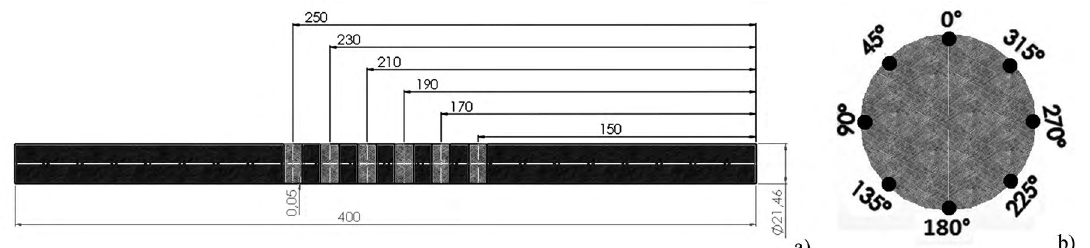
Figure 4. Position of residual stresses measurement (a) along the bar and (b) on the peripheral positions.